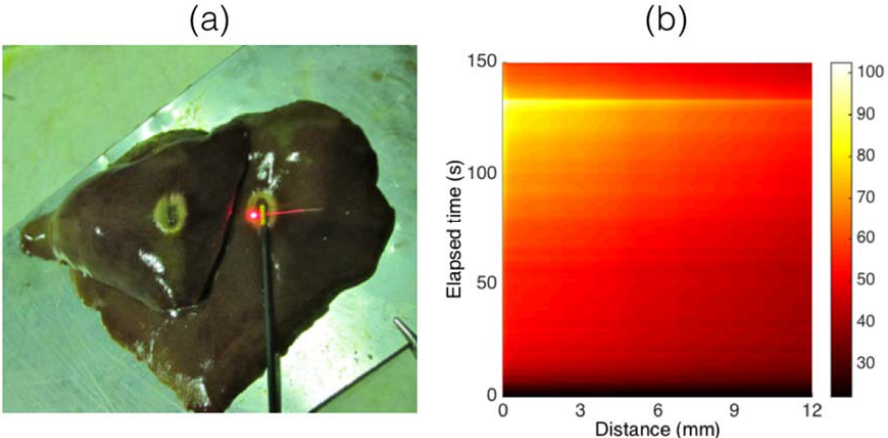
Figure 9. CFBG for in situ temperature detection in RFA; image adapted from [89]. ( a ) Positioning of the CFBG in the ablated tissue; ( b ) example of a measured thermal map (the colorbar reports temperature in °C).